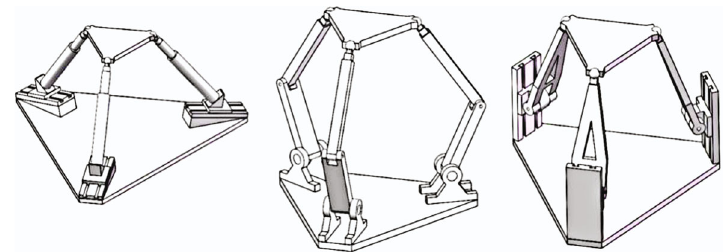
Figure 18: Combinations of modular units.